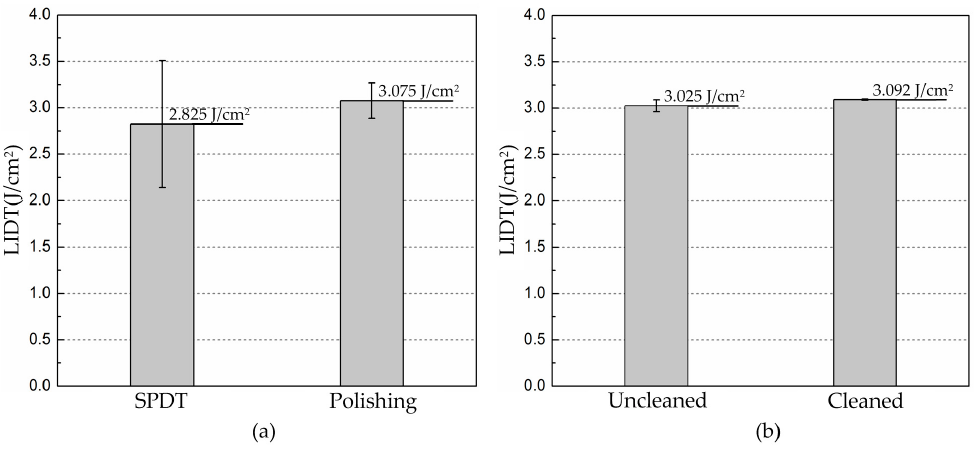
Figure 7. Comparison of LIDT and its stability ( a ) After SPDT and WDUP ( b ) Uncleaned and cleaned after WUDP.